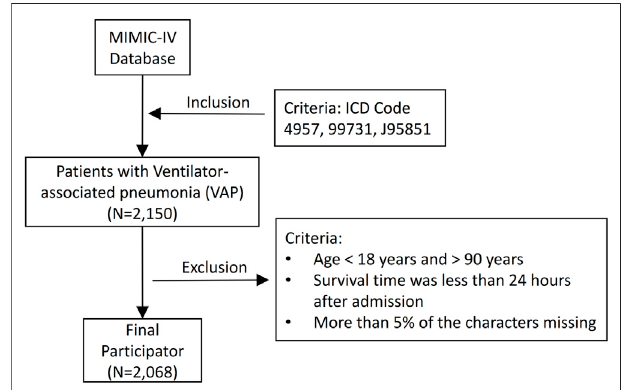
FIGURE 1 | Flowchart of patients ’ inclusion and